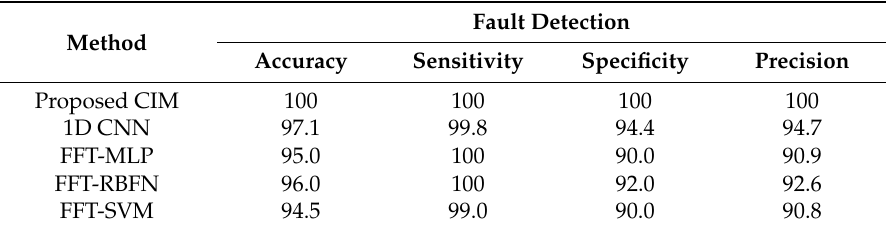
Table 5. Bearing fault detection performance of the proposed